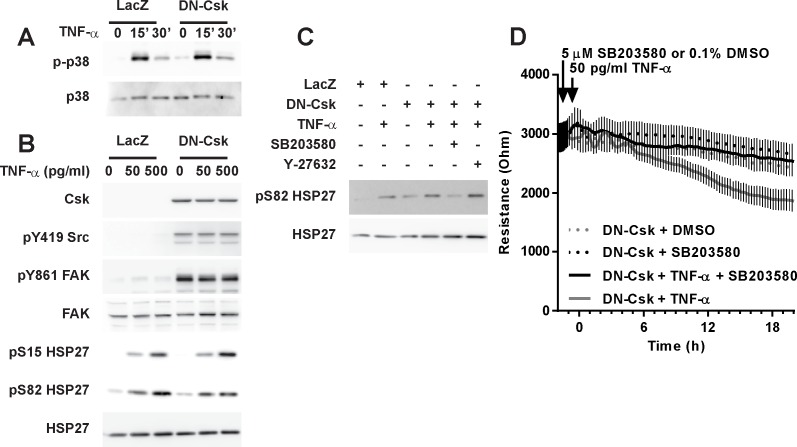
p38 activity is required for the increased permeability in LD-TNF/DN-Csk cells.Cells were seeded at confluence and incubated for 72 hours. Then, growth media was replaced by low serum media and cells were infected with adenovirus to express either LacZ (control) or DN-Csk. A, 16 h later, cells were treated with low dose TNF-α for 15 or 30 minutes and assayed for p38 phosphorylation by Western blot. B, Cells were treated with low or high dose TNF-α and assayed for p38 and SFK activity 30 minutes post-treatment (as measured by pY-Src, pY-FAK and pS-HSP27) by Western blot. C, Cells were pretreated for 30 minutes with either DMSO (vehicle), SB203580 (p38 inhibitor) or Y-27632 (ROCK inhibitor), treated as in A, and assayed for pS82-HSP27 by Western blot. D, Cells were pretreated with either DMSO or SB203580 30 minutes prior to TNF-α addition and then TEER was measured on ECIS electrodes for an additional 20 hours. Data presented as mean±SEM. Notice that p38 inhibition reversed the loss of barrier function in LD-TNF/DN-Csk cells. Results are representative of at least three independent experiments (n = 2–4 per experiment). Bar graph and statistical analysis of TEER for the 20 h time point corresponding to C is shown in S6G Fig.